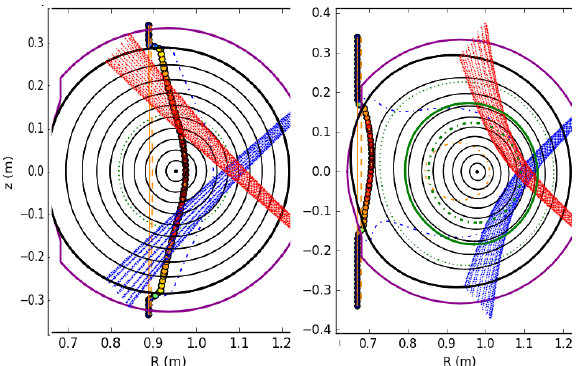
Fig. 1. Left: Plasma equilibrium and main EC resonances when operating at 4.7 field in the vessel centre. Probe beam (in red) is launched from the bottom right side, while the beam is received at the top right side (in blue) intersecting the probe on the equatorial plane. Right: the same with magnetic field at 3.6 T in the vessel center. The thin vertical (solid and dashed) lines correspond to the EC cold and warm resonances, while the Upper Hybrid (UH) resonance is marked by dots in